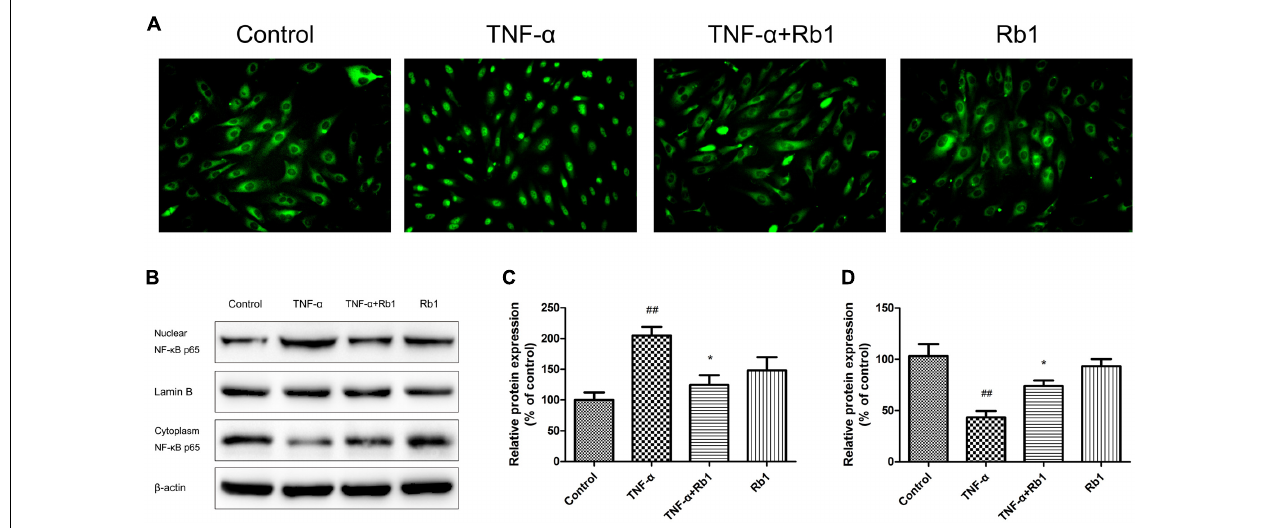
FIGURE 6 | The protective effects of ginsenoside Rb1 on TNF- α -induced injury in HUVECs are NF- κ B-dependent. HUVECs were incubated with ginsenoside Rb1 (20 µ g/mL) for 8 h prior to treatment with TNF- α for 24 h. (A) The localization of p65 in HUVECs was detected by immunofluorescence and visualized by fluorescence microscopy. (B) Western blot analysis was performed to examine nuclear and cytoplasmic NF- κ B p65 expression. (C) Densitometric analysis was performed to quantify nuclear NF- κ B p65 protein levels. (D) Densitometric analysis was performed to quantify cytoplasmic NF- κ B p65 protein levels. Data were expressed as the mean ± SD of three independent experiments. ## P < 0.01 vs. control group; ∗ P < 0.05, ∗∗ P < 0.01 vs. TNF- α treatment